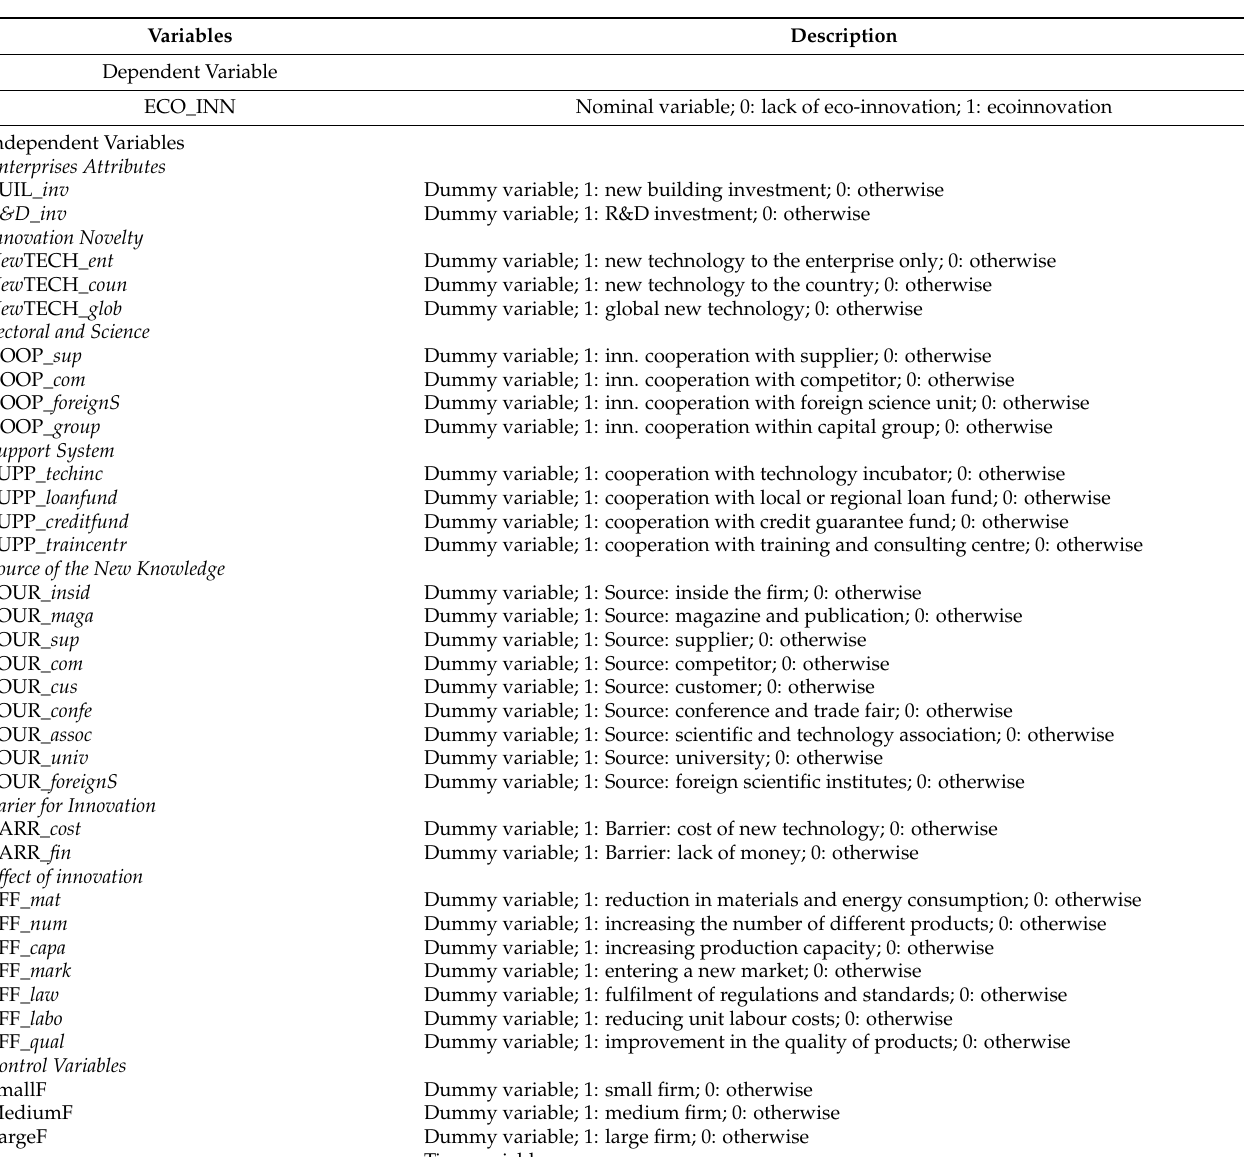
Table 2. Definition of the variables used in